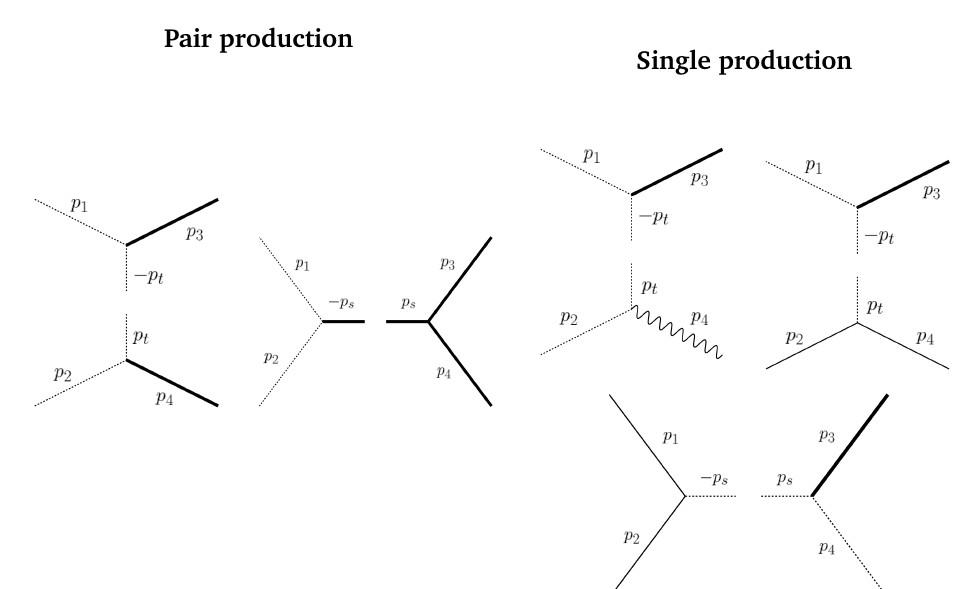
Figure 5: Schematic representation of Higgs-mediated contributions to DM produc- tion. The DM particle is depicted by a thick line, the Higgs doublet by a thin dotted line, and fermions by a thin solid line. All momenta are incoming, and we define = p + p = p + p p , p . For pair production, a u-channel contribution related by s t 1 2 1 3 crossing to the t-channel one should be included as